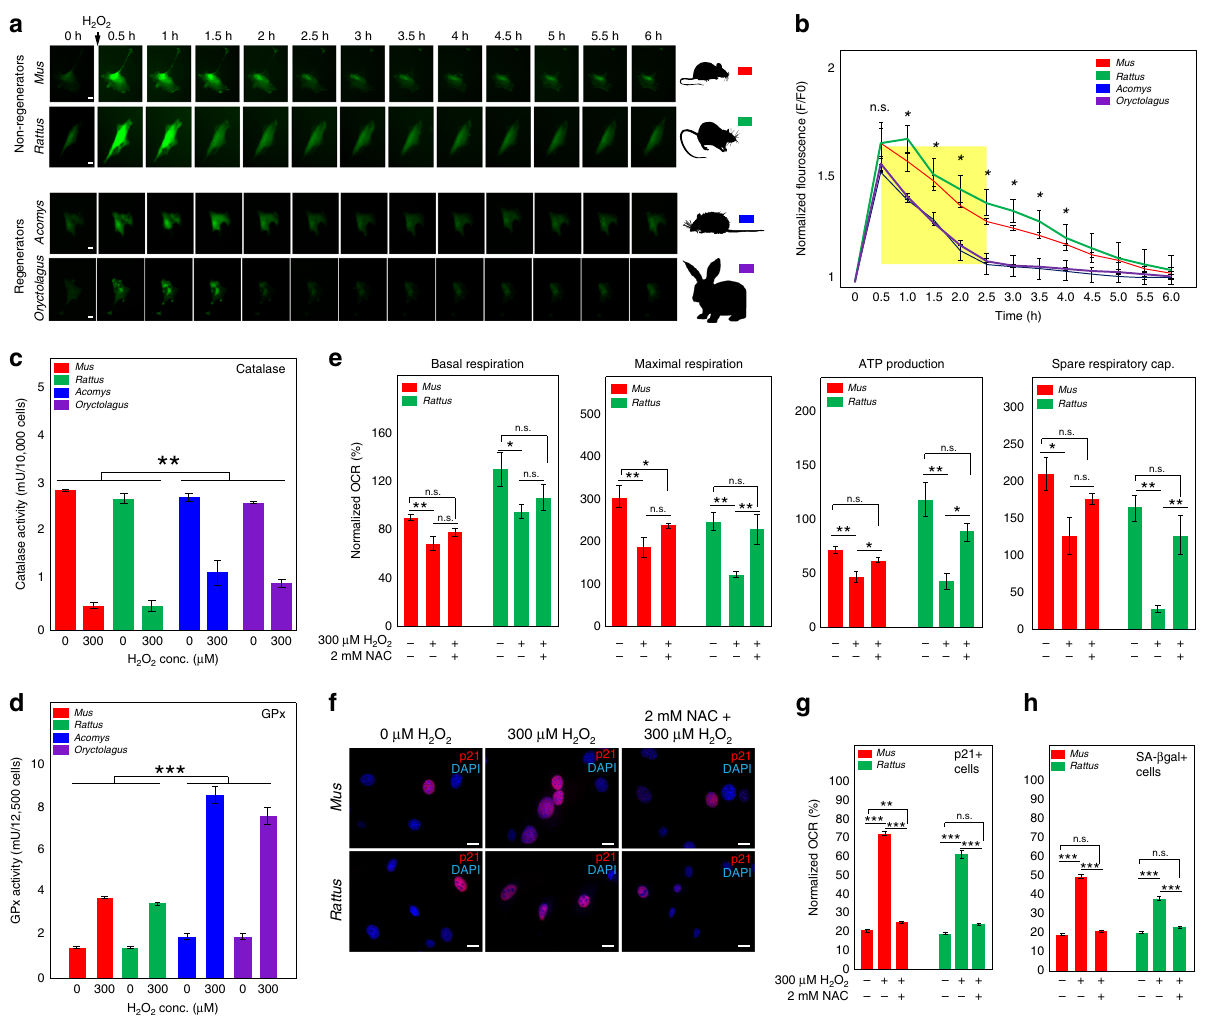
Fig. 7 Regenerators rapidly detoxify exogenous hydrogen peroxide via increased GPx activity. a Representative images for a single live-imaged cell transfected with HyPer which captured every 30 min over 6 h. b Fluorescence intensity ratios (F/F0) were calculated for >20 cells/cell lines for all four species ( n = 3 lines/species). A linear model was used to detect H 2 O 2 detoxi fi cation rate and ANOVA was used to detect signi fi cant differences between species. F/F0 quanti fi ed 30 min after H 2 O 2 treatment were not signi fi cantly different between species (ANOVA, F = 1.2153, P < 0.3651 and